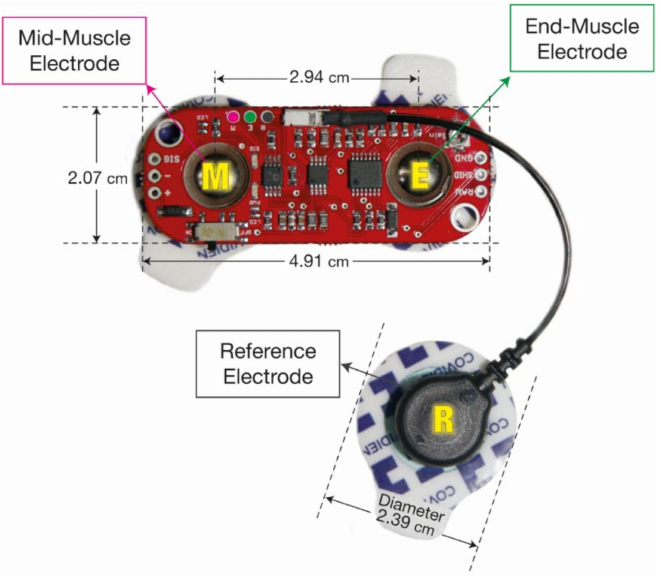
Figure 1. EMG sensor and electrodes used in the experiments. The image is modified from